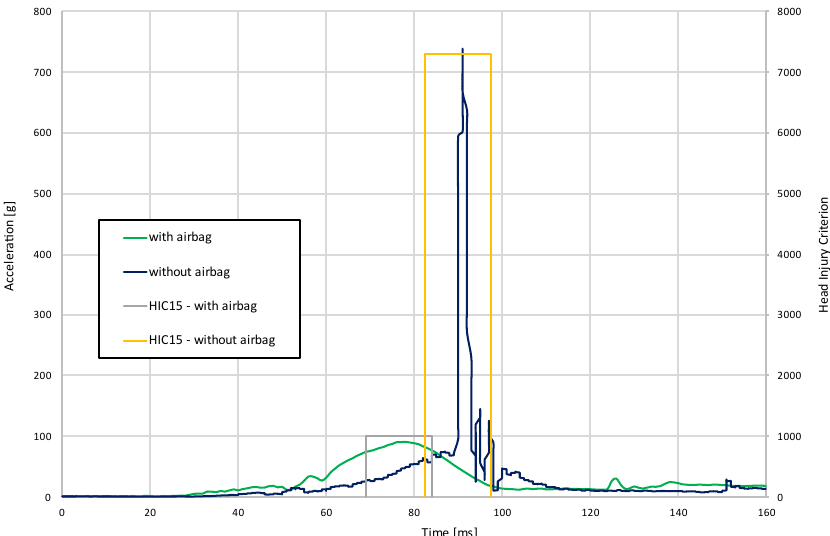
Figure 8. Resultant acceleration and head injury criterion.